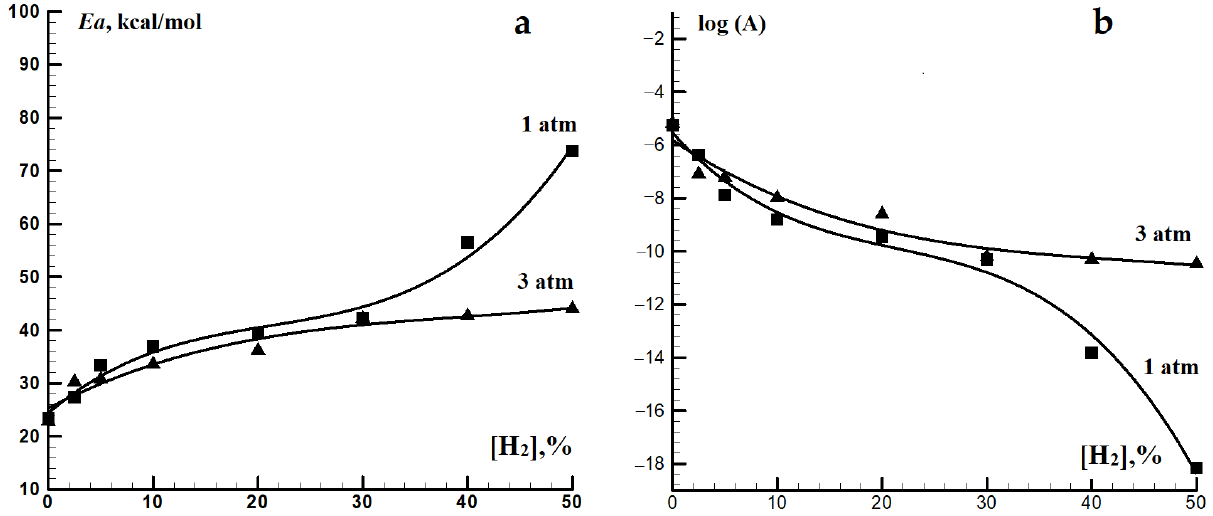
Figure 3. Dependence of the effective activation energy E a ( a ) and the pre-exponential factor A ( b ) in the Arrhenius expression for the autoignition delay time for methane – hydrogen-air mixtures on the concentration of hydrogen at P 0 = 1 and 3 atm.